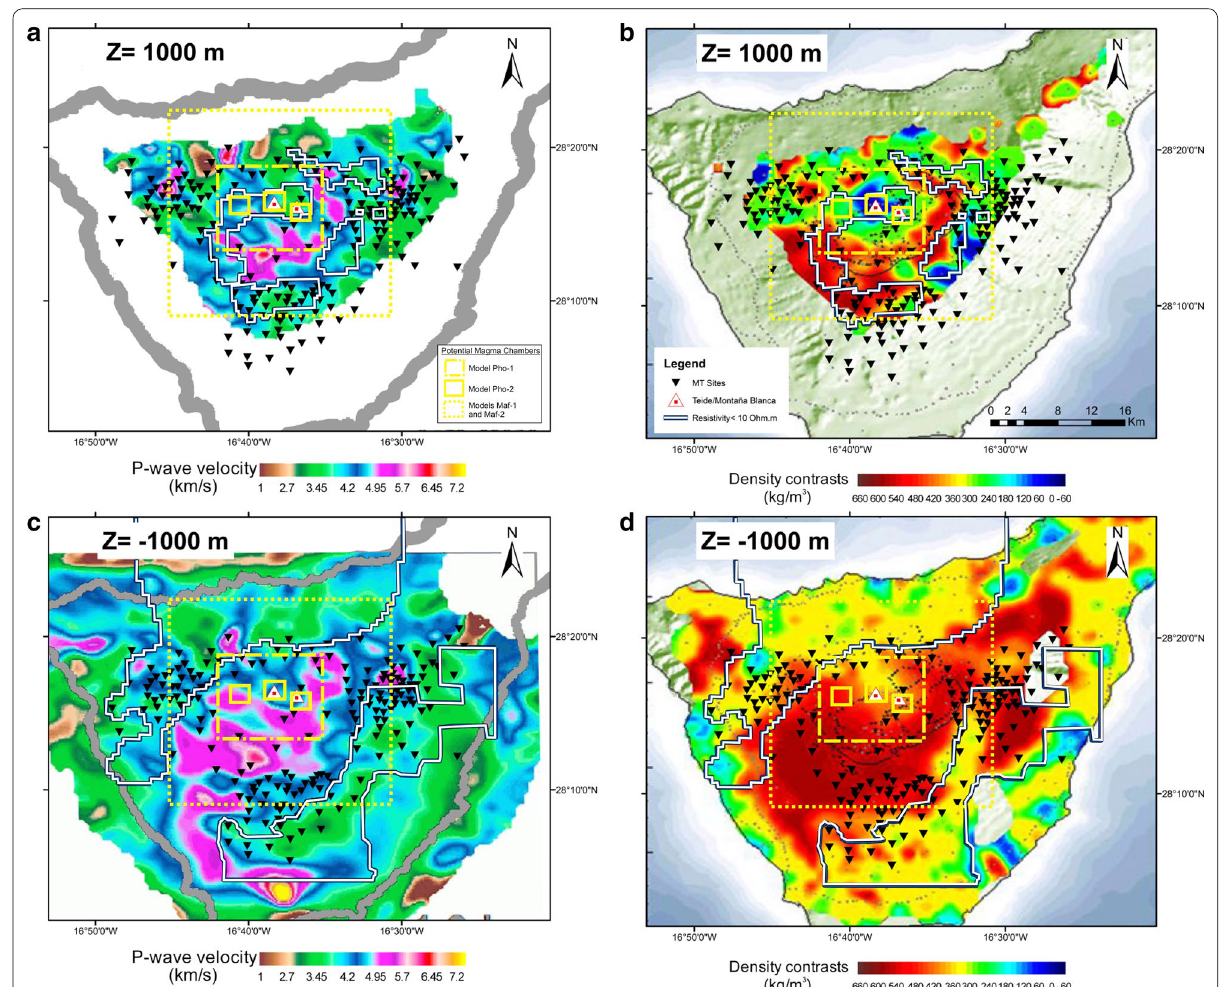
Fig. 4 Different geophysical models. Comparison between the 3‑D P wave velocity model derived by García‑Yeguas et al. (2012) and the original 3‑D resistivity model at: a 1 km a.s.l; c 1 km b.s.l. Comparison between the density contrast model derived by Gottsmann et al. (2008) and the original 3‑D resistivity model at: b 1 km a.s.l; d 1 km b.s.l. White line corresponds to resistivity values < 10 Ωm, which has been interpreted as the hydrothermal alteration clay cap. Grey triangles correspond to the MT sites. White triangles correspond to Teide (left) and Montaña Blanca (right). Yellow lines correspond to the potential magma chambers considered on the different test